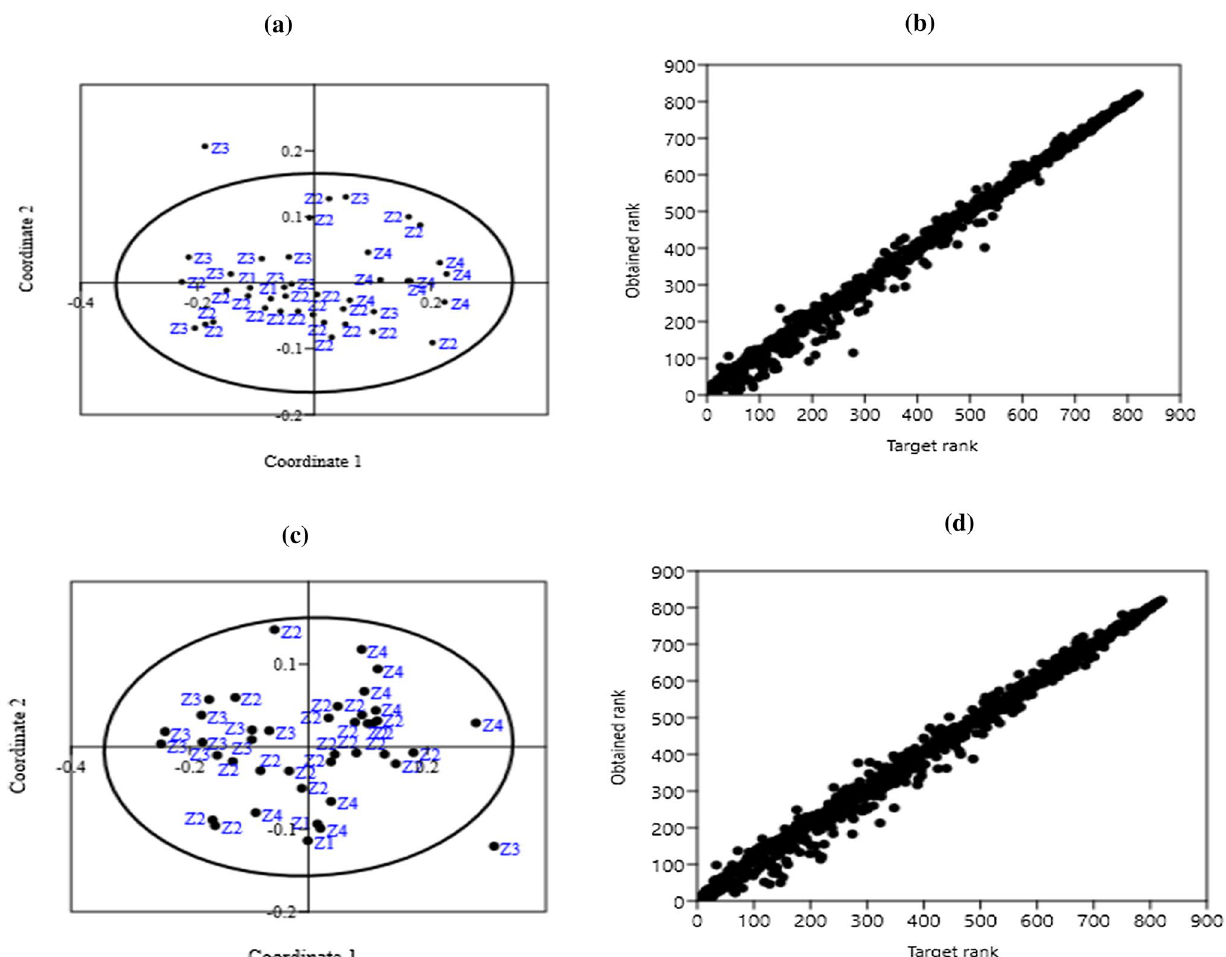
Fig. 5 a NMDS scatter plot (95% eclipse), b NMDS Shepard 2-D plot, stress = 0.04567, R 2 for axis 1 = 0.7512 and axis 2 = 0.1149 for pre-monsoon season c NMDS scatter plot (95% eclipse) and d NMDS